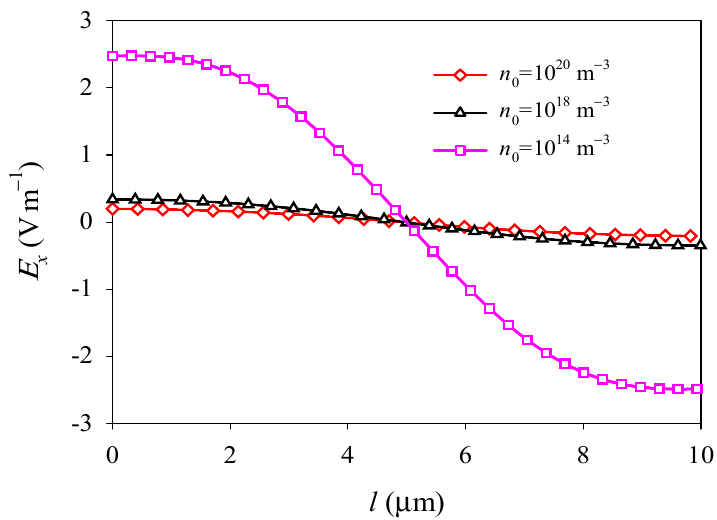
Figure 9. Electric field E x along the midline y = d/ 2 versus the initial electron concentration n 0 .